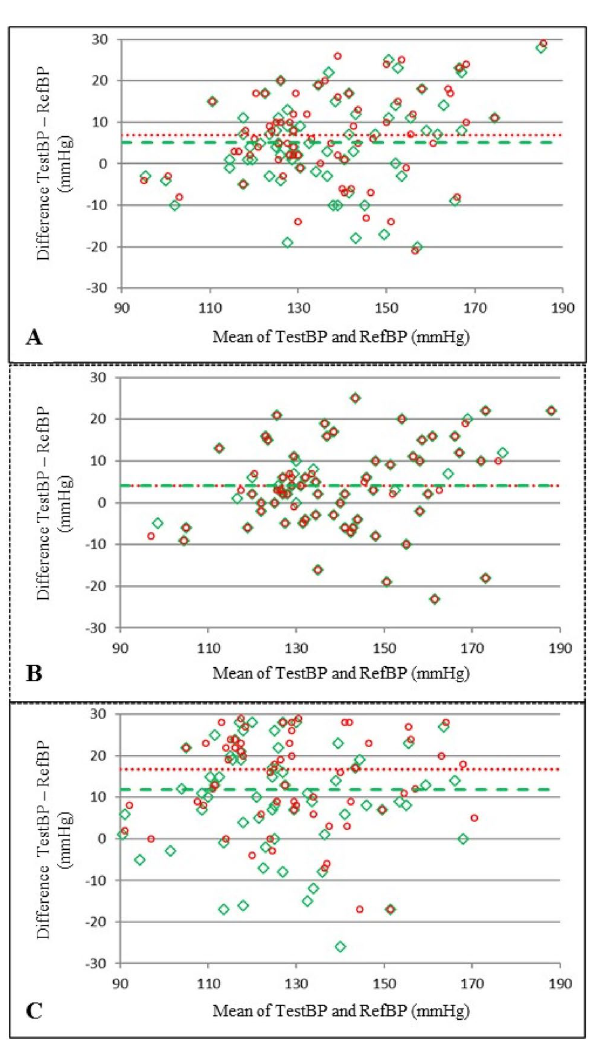
Figure 1. Bland Altman plots comparing systolic mean ( A ) 24 h, ( B ) awake and ( C ) asleep. BP values of TestBP-V1.4 /V1.5 and Ref BP and RefBP. Horizontal lines indicate mean differences Legend: Version 1.4—open red circle, Version 1.5—open green diamond, Version 1.4—red dotted line, and Version 1.5—green dashed